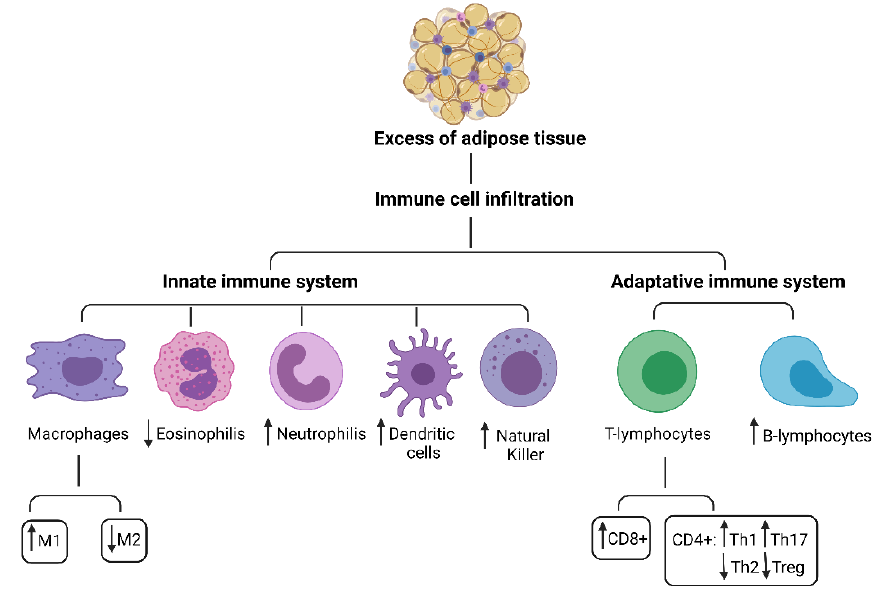
Figure 1. Innate and adaptive immune system cells in adipose tissue.